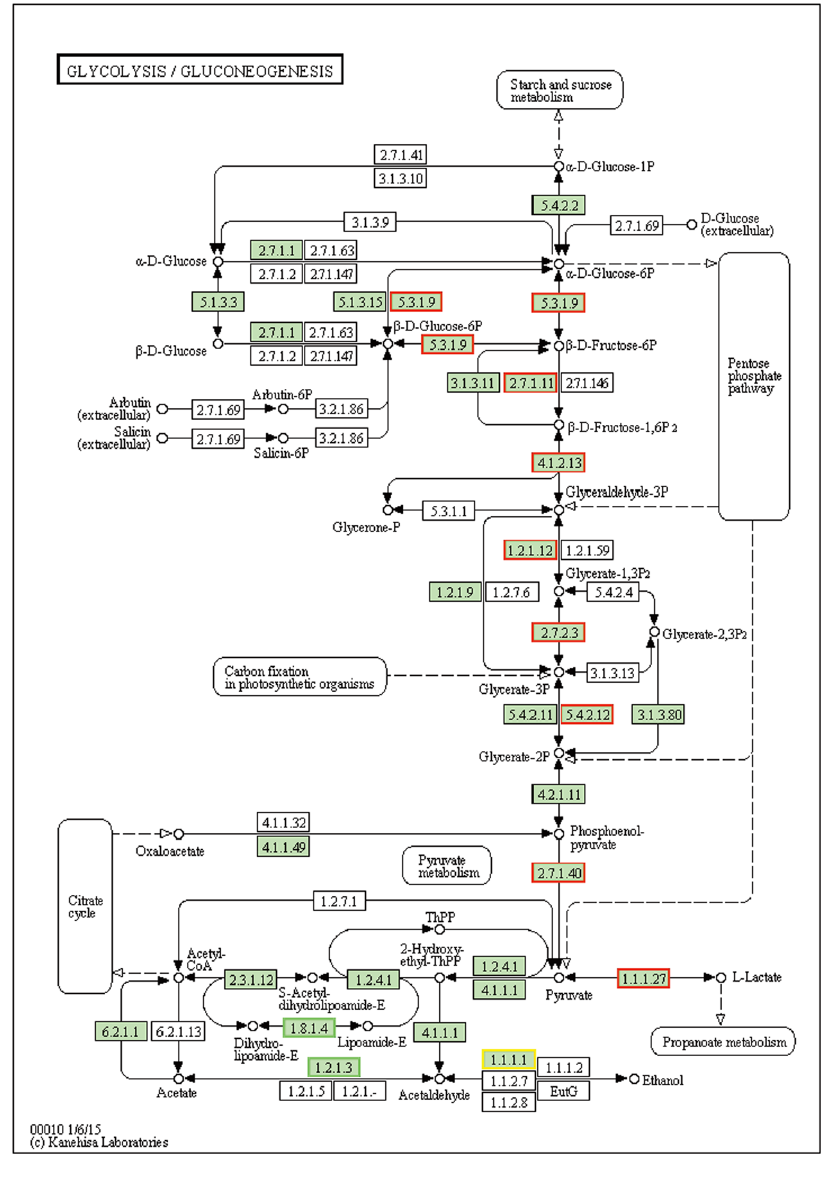
Figure 4. Unigenes predicted to be involved in the glycolysis pathway derived from KEGG database 61 . Red outline indicates significantly increased expression at 3 h compared with 0 h waterlogging treatment; green outline indicates significantly decreased expression; yellow outline indicates proteins encoded by both up-and down-regulated